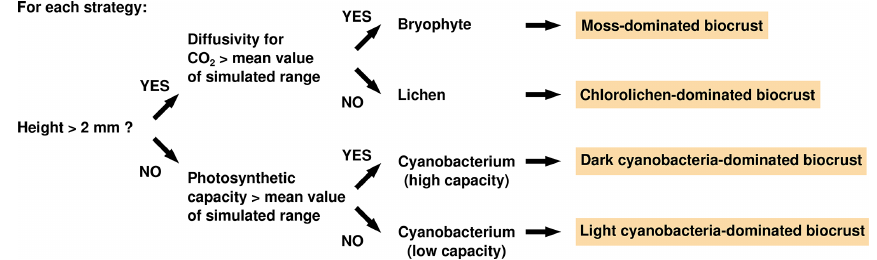
Figure 2. Scheme to assign each simulated strategy in the LiBry model to one of four biocrust types for dryland